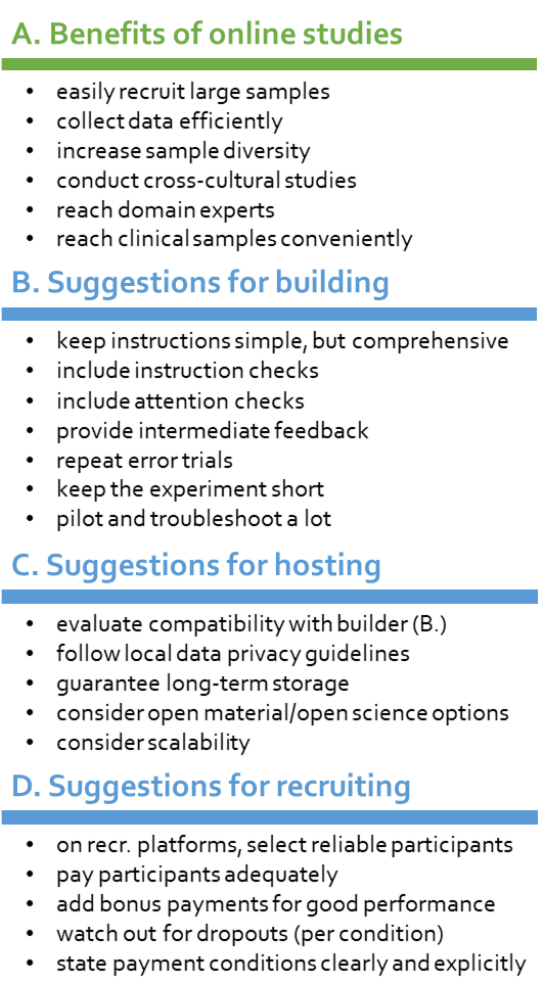
Figure 2. Simplified overview of benefits of online experimentation and recruiting ( A ) as well as suggestions for building online experiments ( B ), hosting online studies ( C ) and recruiting participants online ( D ).